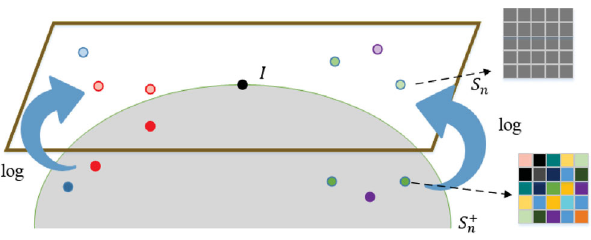
Fig. 2 Logarithmic